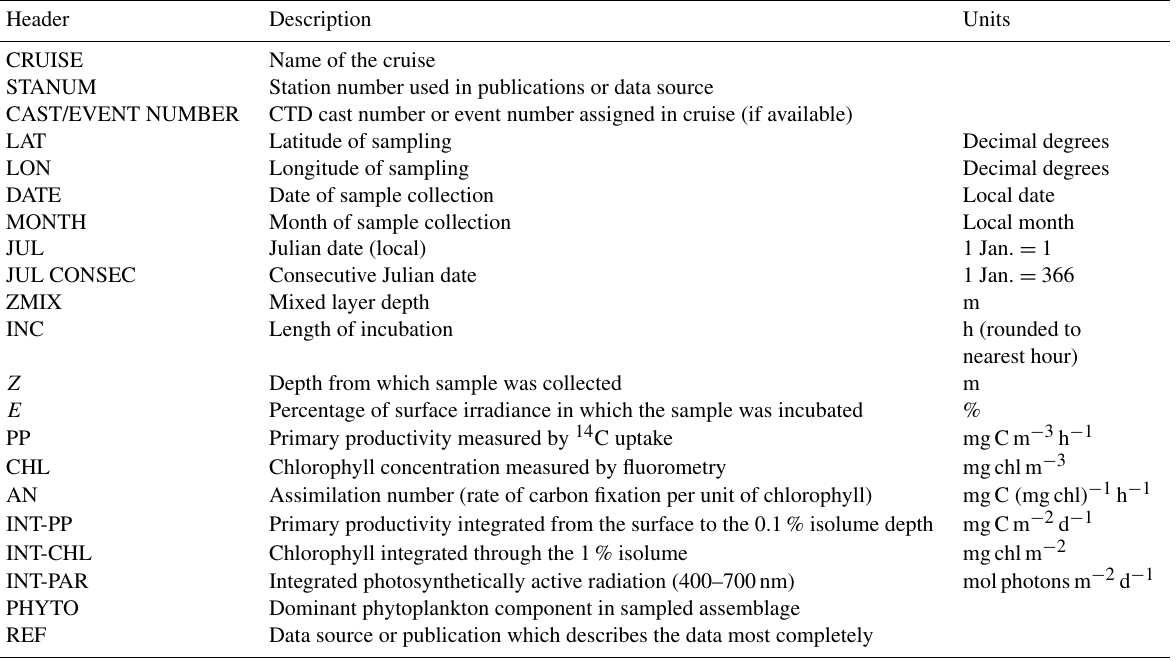
Table 2. Name of the columns provided in the primary productivity table along with a description of the variable and its units.